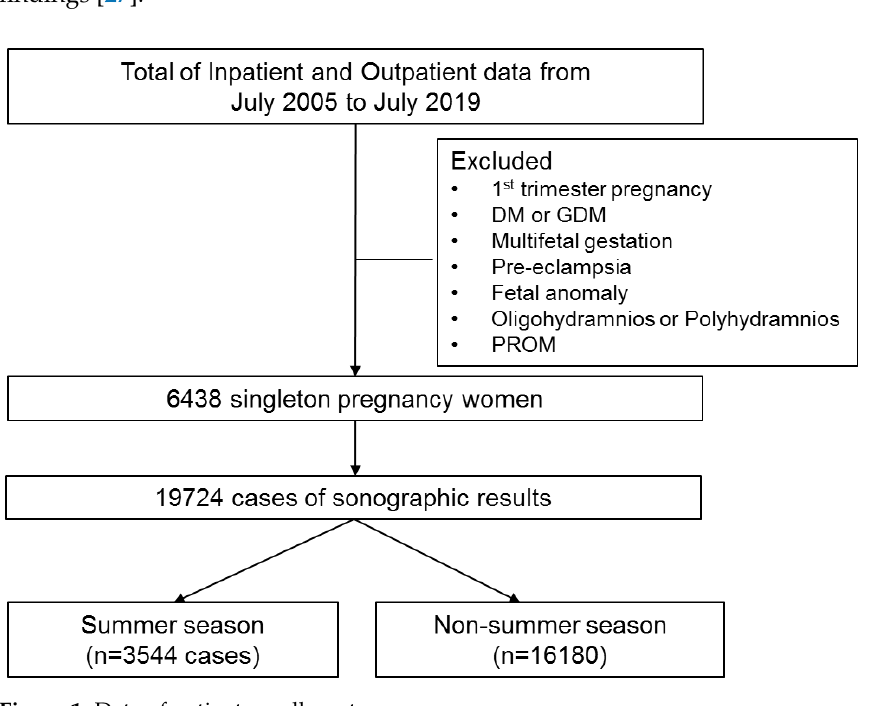
Figure 1. Data of patient